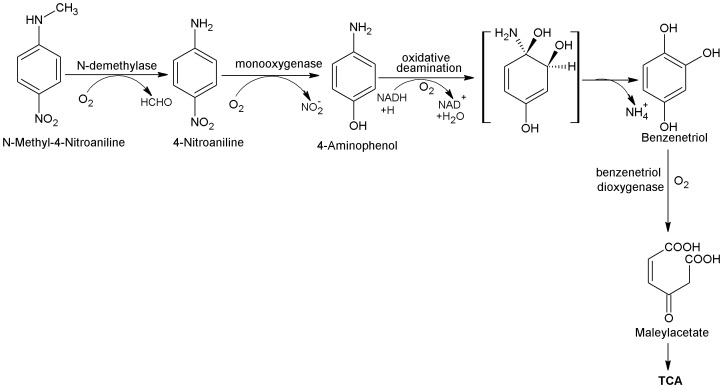
Proposed metabolic pathway for aerobic degradation of MNA by Pseudomonas sp. strain FK357.